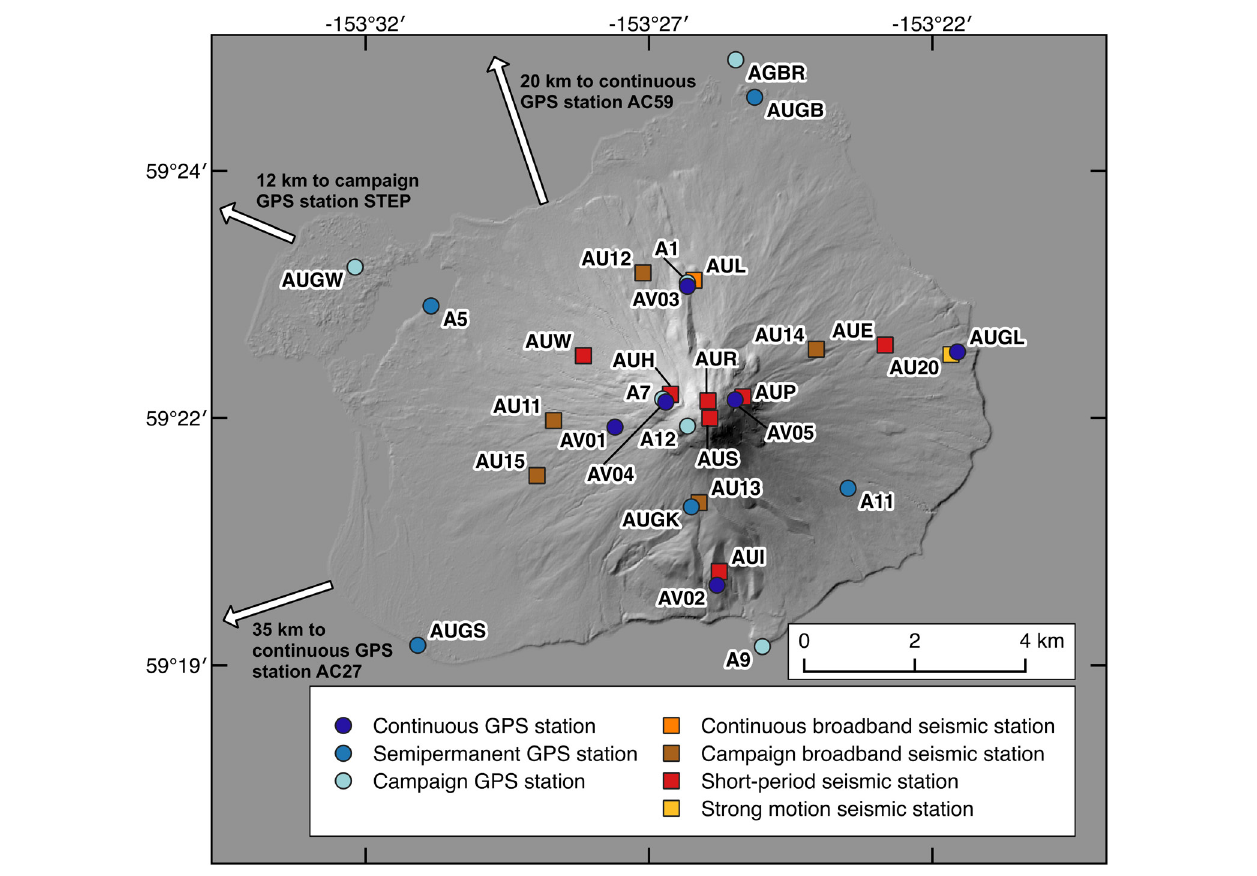
FIGURE 8 | Map showing seismic and GPS stations at Augustine Volcano prior to the 2006 eruption. Seismic station locations are from Power and Lalla (2010). GPS station locations are from Cervelli et al. (2010); see also Pauk et al. (2010). For additional details, see original publications. Hillshade is an ESRI Image Service product from 2013 accessed through ArcGIS